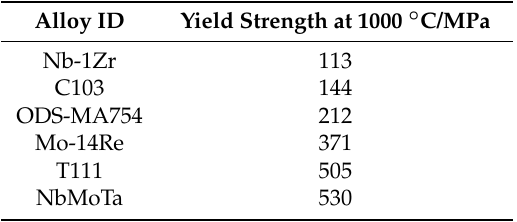
Table 6. The comparison of high temperature (1000 ◦ C) performance of aerospace